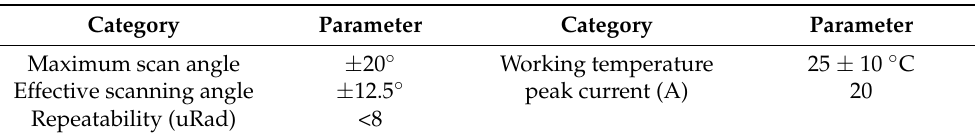
Table 1. Parameters of the vibrating lens.